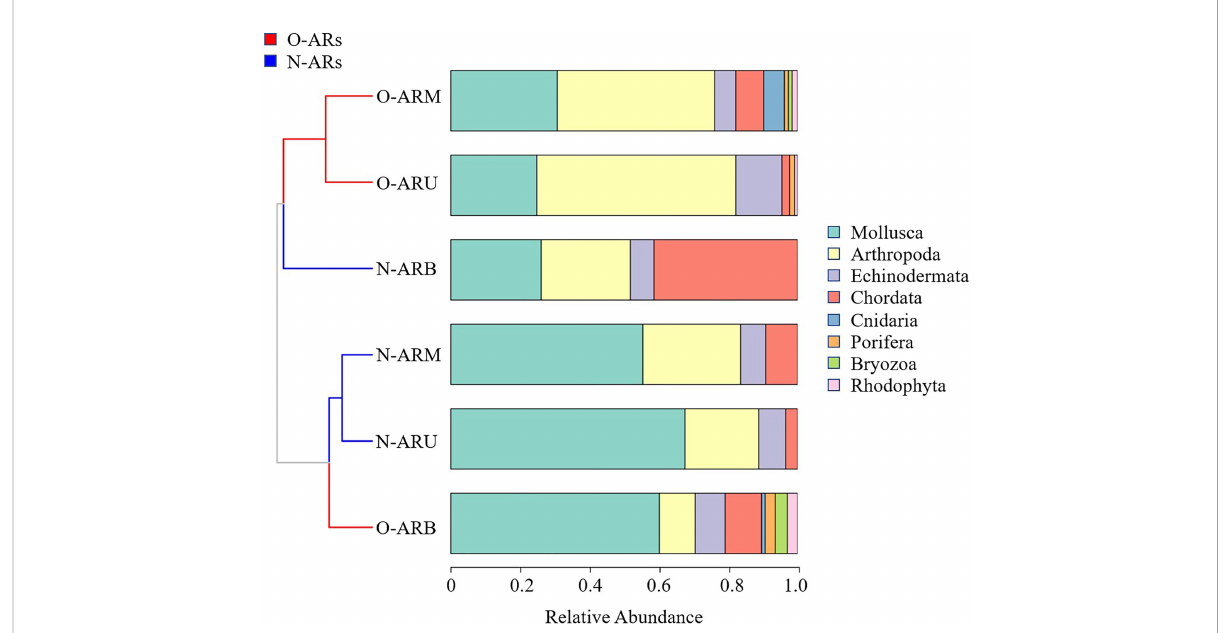
FIGURE 3 Analysis of the composition of attached organisms at each sampling location on the ARs with different construction times. The two colours of the cluster tree branches indicate that hierarchical clustering based on the Bray-Curtis dissimilarity divides the samples into two categories. Different colours in the histogram represent different phylum. The area size of the colour represents the relative abundance of its corresponding phylum.